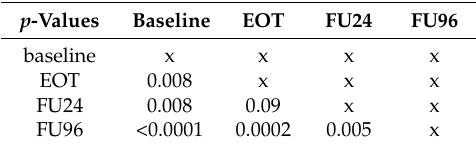
Table 3. Statistical significance of differences calculated with Wilcoxon signed rank test ( p ), between LS values at particular examination time points.